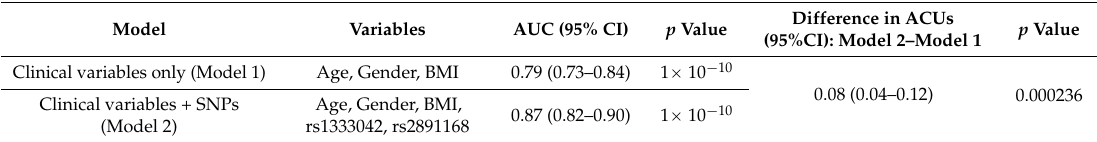
Table 4. Comparison between two multivariate models with and without CAD associated SNPs. AUC: area under